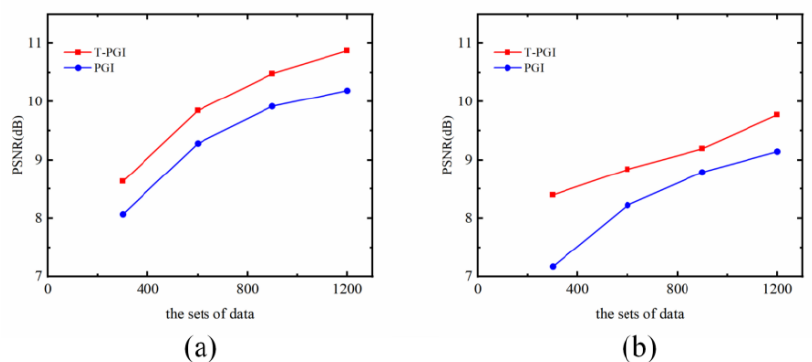
Figure 6. PSNR curves of the reconstruction result “GI” and “ZHONG” of pseudo-inverse ghost imaging (PGI) and T-PGI; ( a ) the PSNR curves of the “GI” of PGI and T-PGI; ( b ) the PSNR curves of “ZHONG” of PGI and T-PGI.